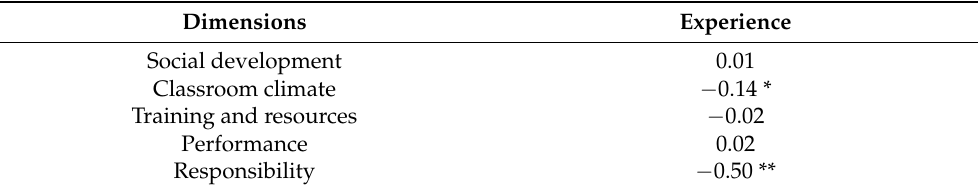
Table 4. Correlations between the dimensions and the variable years of